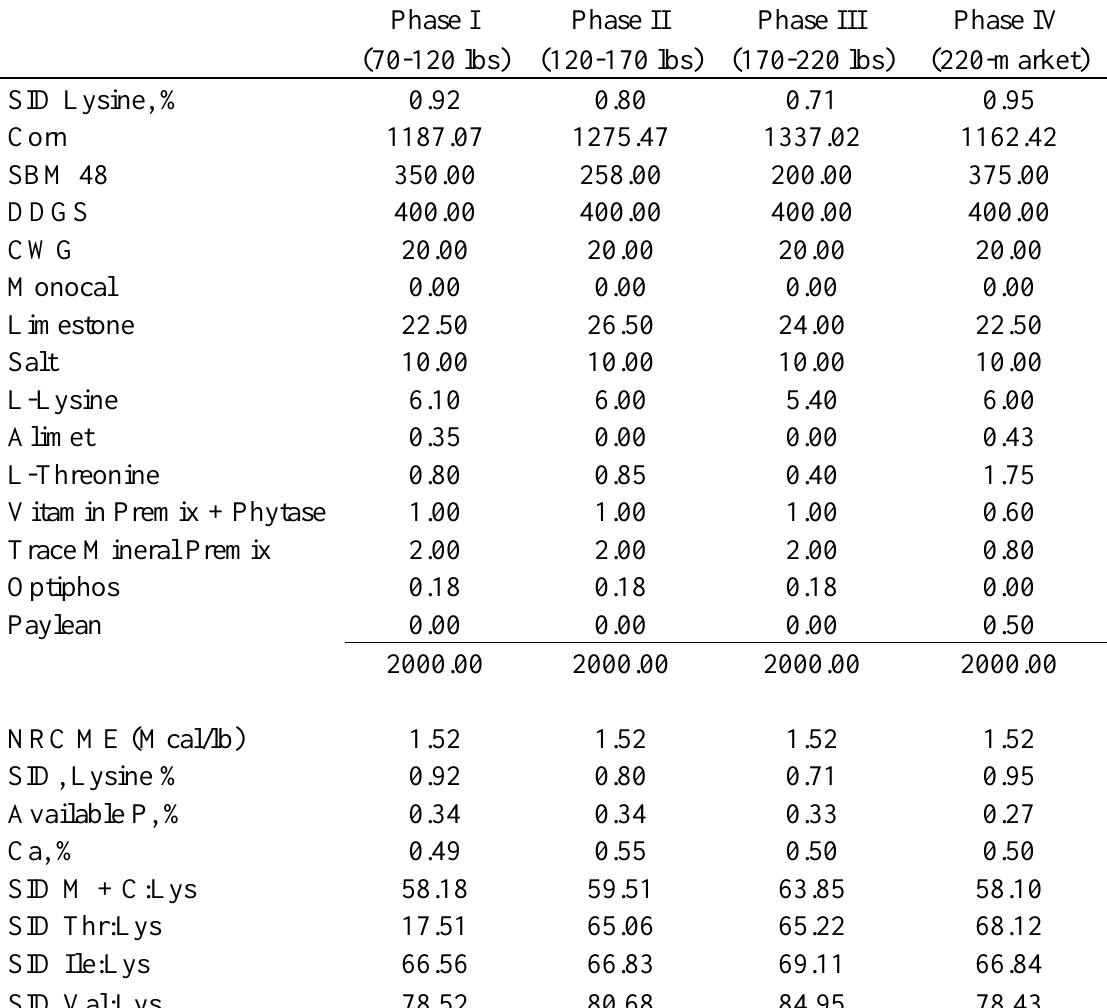
Table 2 . Composition of the grower-finisher diets containing 20%